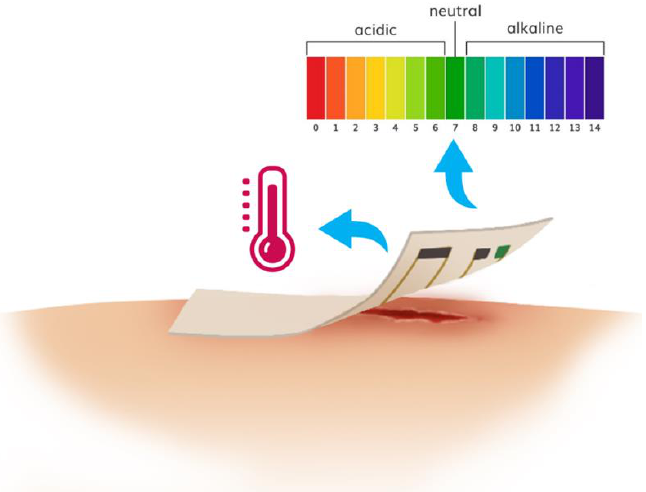
Figure 1. Wearable sensors/systems for wound related biomarkers (e.g., pH, temperature) detection to monitor wound healing status.